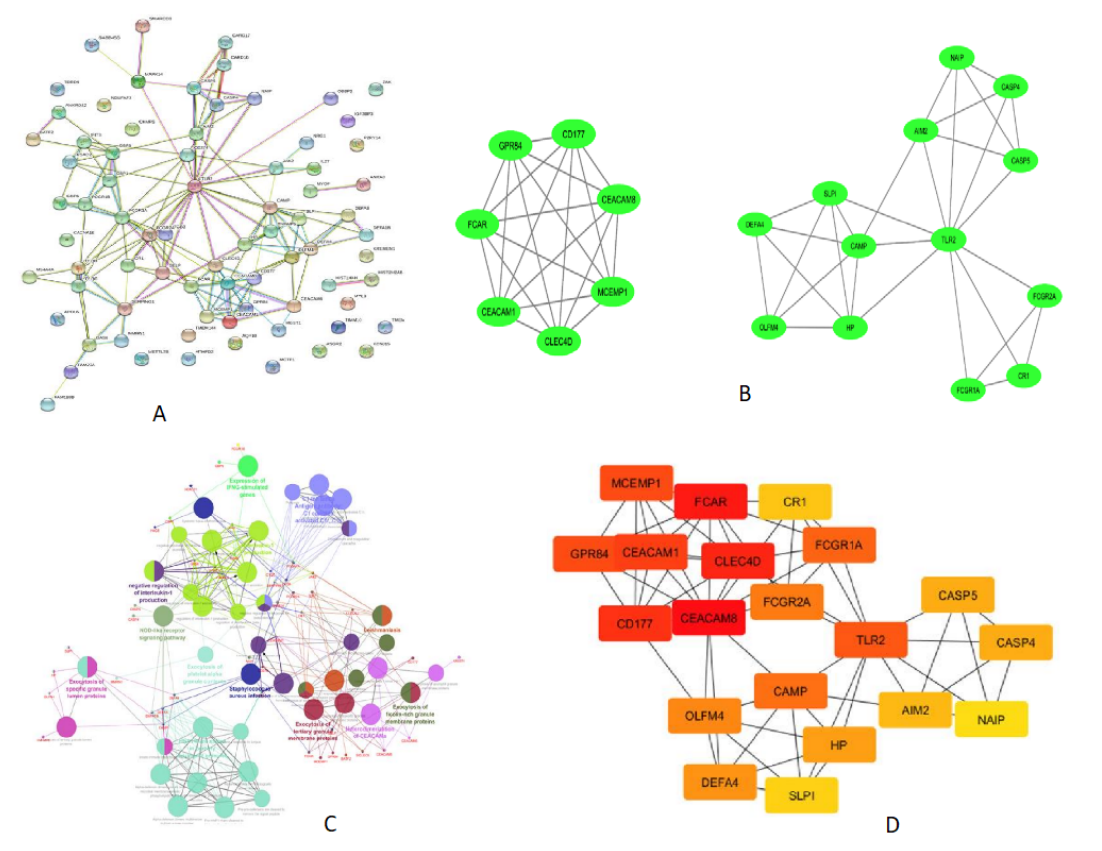
Figure 2. PPI network displaying the interaction of proteins coded by the upregulated genes derived from ATB vs. LTBI data. ( A ) Results of STRING analysis ( p value < 1 × 10 − 16 ). PPI network with 76 nodes connected to 151 edges. ( B ) Closely connected subnetworks identified by MCODE analysis plugin of cytoscape. Two clusters enriched in top with cluster score above 3 are shown. ( C ) Functionally enriched edges identified from PPI network using clueGO/cluepedia of cytoscape software. Network connectivity among GO term and pathway determined based on the interaction of functional cluster, edges (kappa score > 0.4), and enriched terms/pathway with p value < 0.05. Functional groups are denoted in different color codes; the most enriched functional term is indicated in bold color. ( D ) Cytohubba (MCC method) analysis explored the most important hub nodes; nodes in red color indicate a high MCC score, and yellow color node represents a low MCC score.